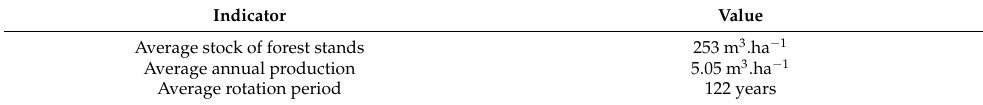
Table 2. Basic dendrometric indicators of forest stands in the study area. Indicator